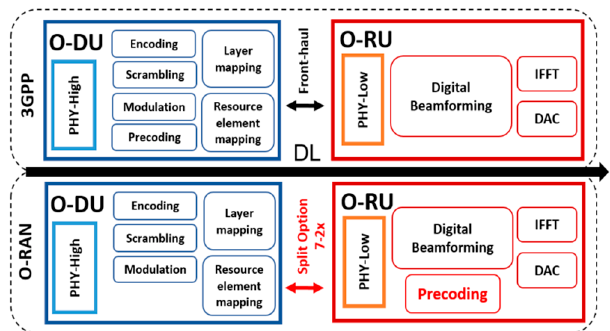
Figure 3. Digital beamforming block diagram in 3GPP and O-RAN.